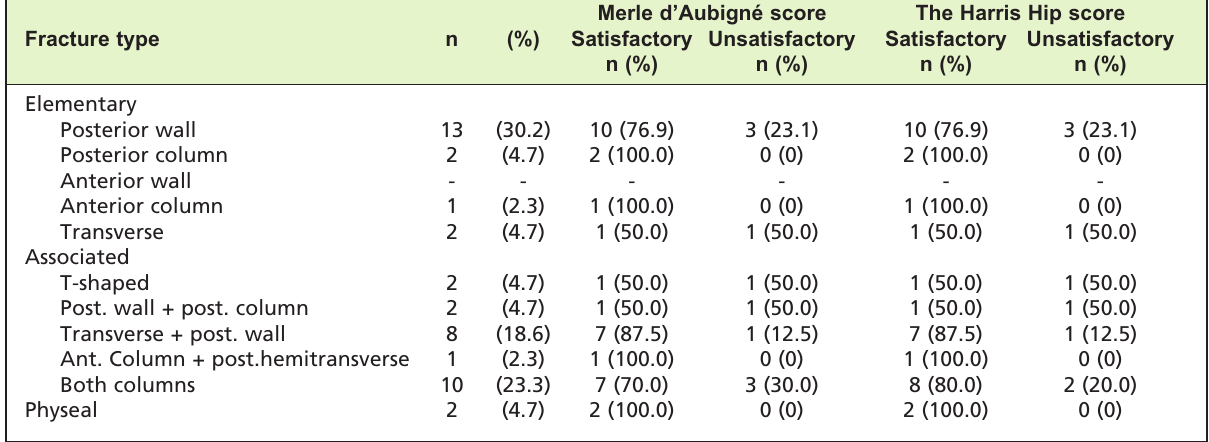
The proportion of fracture type and its functional outcome based on modified Merle d’Aubigné-Postel score and the Table I: Harris Hip score